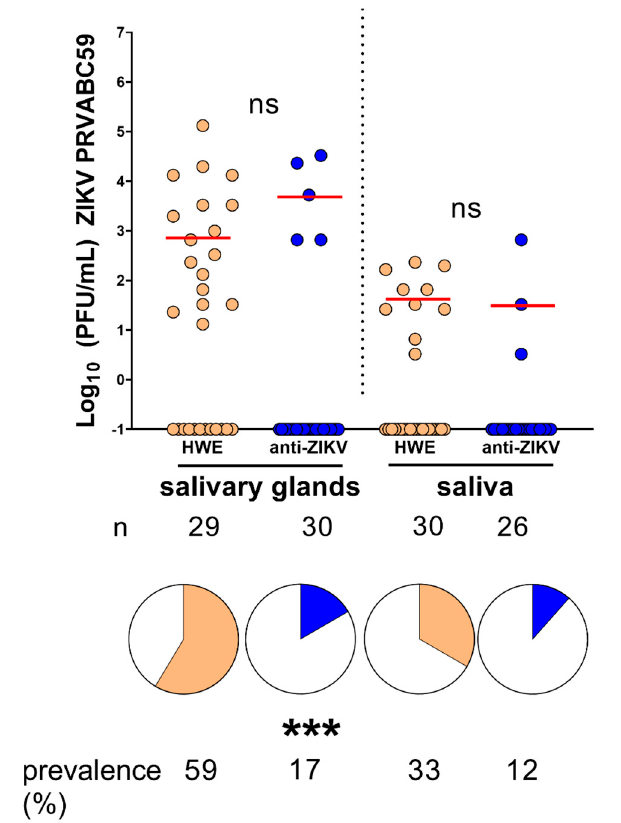
Figure 5. Transgenic anti-ZIKV-NS3 / 4A mosquitoes block ZIKV transmission. Infected salivary glands ( left ) or saliva ( right ) at 14 dpi. Red bars indicate median virus titers. “ns” above graph compares virus titers between infected groups. Stars below pie charts compare infection prevalence; n = number of mosquitoes tested; n = number of mosquitoes tested; ns = not significant; *** = p < 0.001.